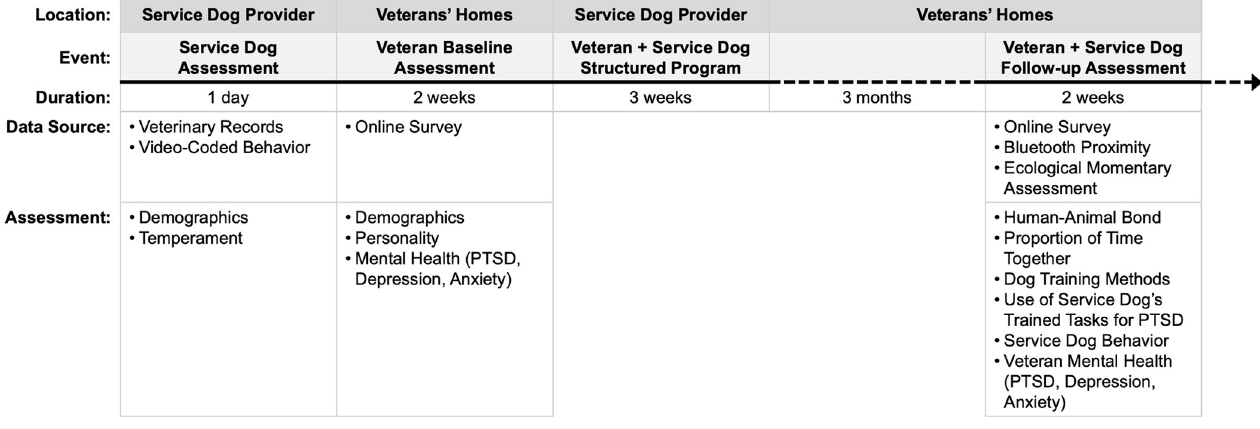
Fig 2. Timeline of study